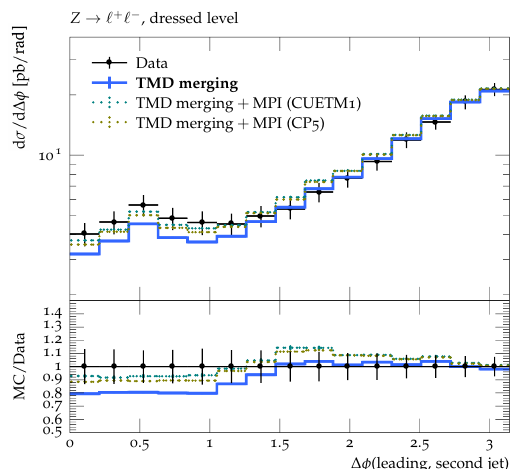
Figure 15 . Di-jet azimuthal separation distribution for Z + ≥ 2 jets events. Experimental mea- √ surements by ATLAS [91] at s = 13 TeV are compared to predictions using the TMD merg- ing calculation. The results including the MPI correction, estimated using the Pythia 8 tunes CUETP8M1 [99] and CP5 [100], are shown with dashed lines.